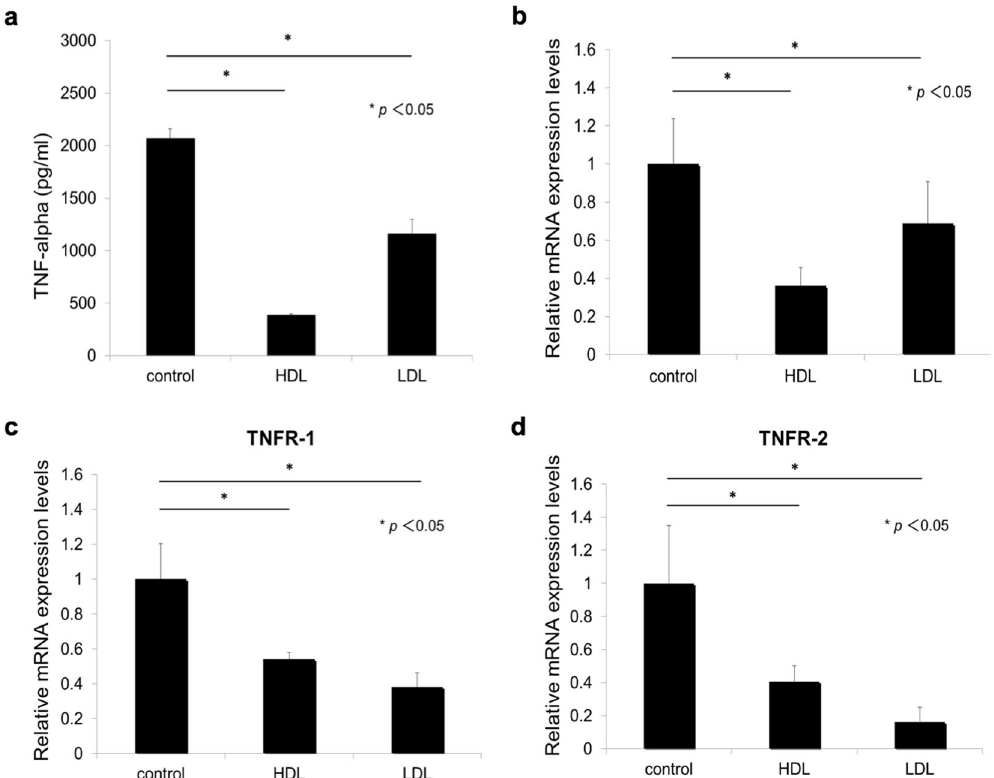
Figure 2. Effect of HDL on the expression of TNF- α and its receptors in BCG-infected macrophages. ( a ) THP1 macrophages were cultured with or without adding HDL or LDL (50 µ g/ml) for 24 hours. The treated macrophages were then infected with BCG (multiplicity of infection = 10) for 24 hours. The amounts of TNF- α in the cell culture supernatants were measured by ELISA. This assay was repeated three times. ( b – d ) THP1 macrophages were cultured with or without adding HDL or LDL (50 µ g/ml) for 24 hours and were then infected with BCG (multiplicity of infection = 10) for 6 hours. TNF- α ( b ), TNFR-1 ( c ), and TNFR-2 ( d ) mRNA expression levels were quantified using real-time PCR (n = 3) and normalized to GAPDH expression. ANOVA was used to test for the differences of in